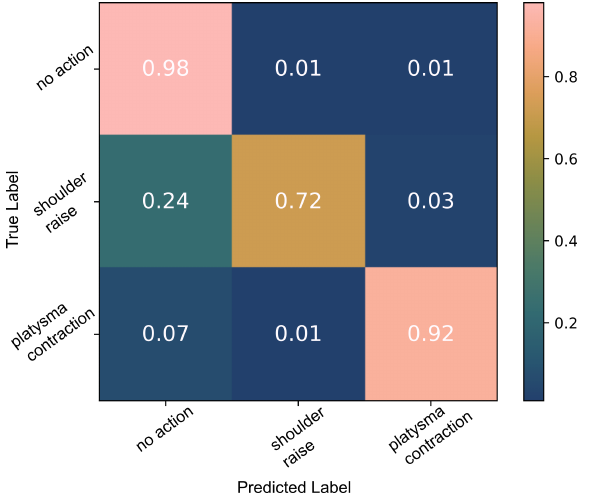
Figure 11. Decision tree classification results of the platysma sensor data captured with Participant2 during shoulder raise and platysma contraction , on a single day.